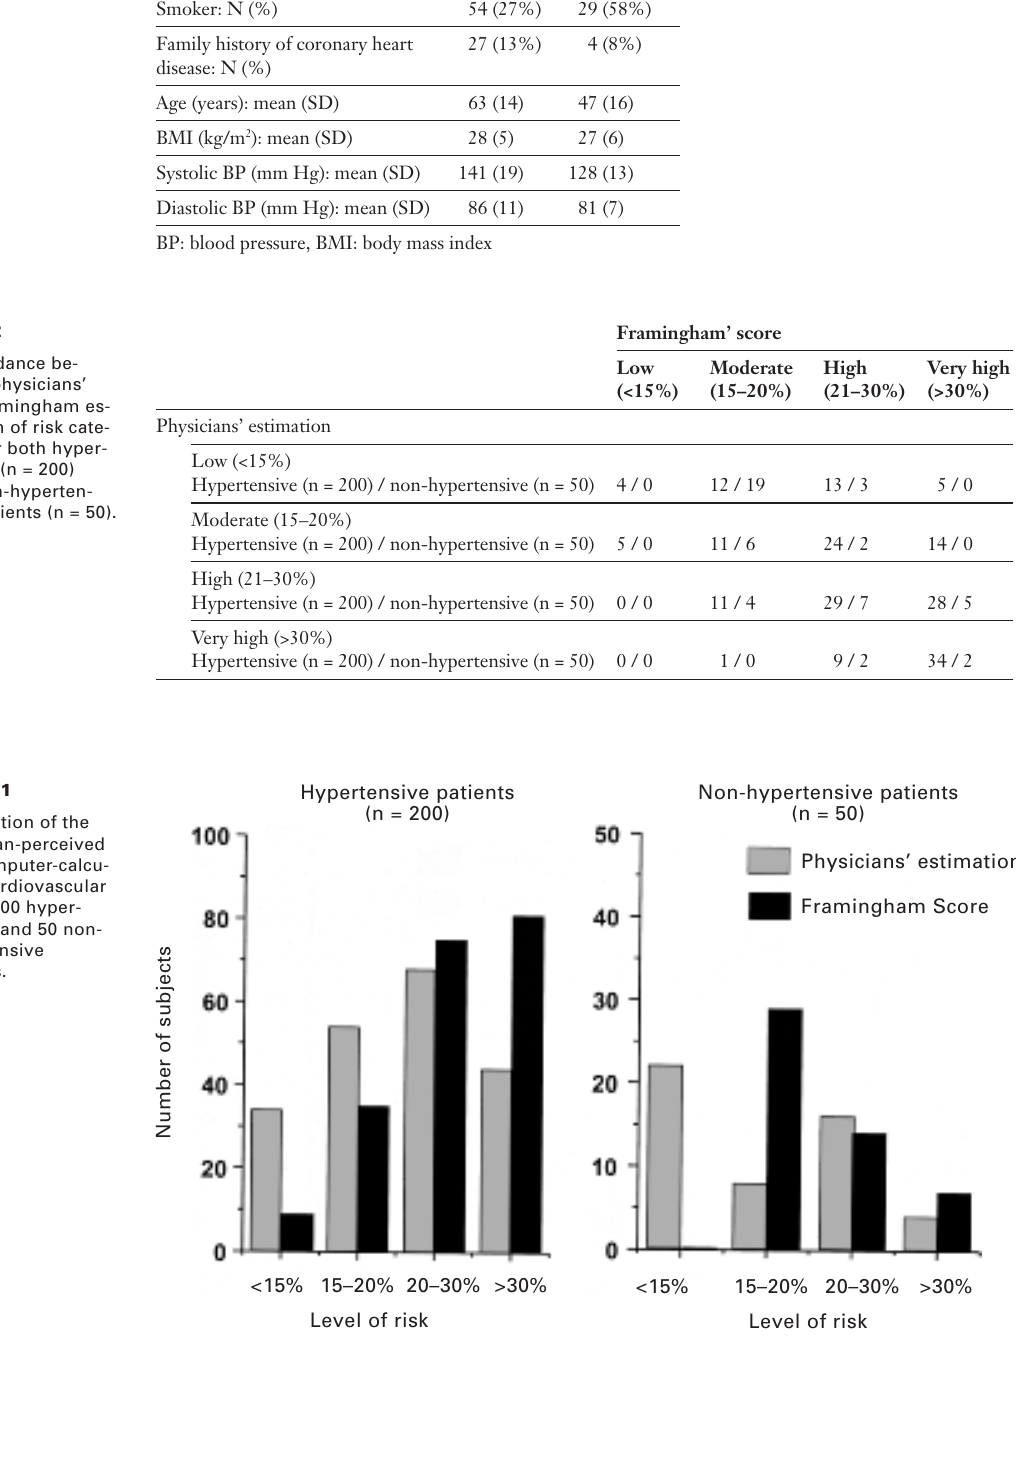
Characteristics of included hyperten- sive (n = 200) and non-hypertensive patients (n = 50).